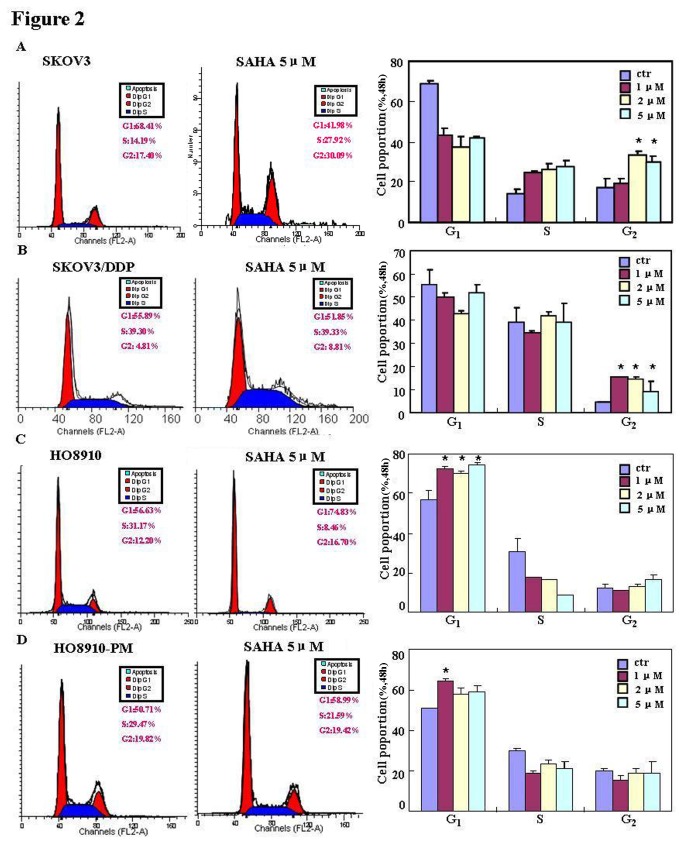
Effects of SAHA on the cell cycle of ovarian carcinoma cells.Flow cytometric analyses(n=3) of ovarian cell-line pairs after PI staining showing that SAHA treatment induces S/G2 arrest in SKOV3 (A) and SKOV3/DDP (B) cells; but conversely, induces G1 arrest in HO8910 (C) and HO8910-PM (D) cells.